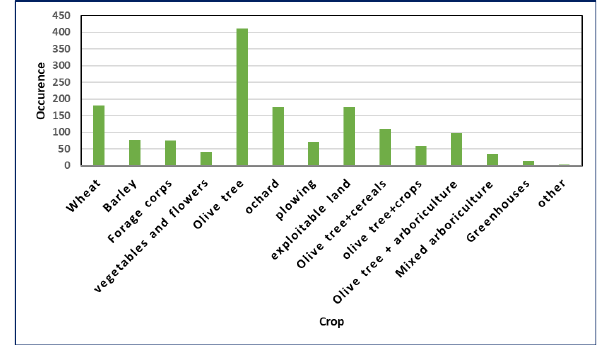
Figure 7. Distribution of observed plots per crop type